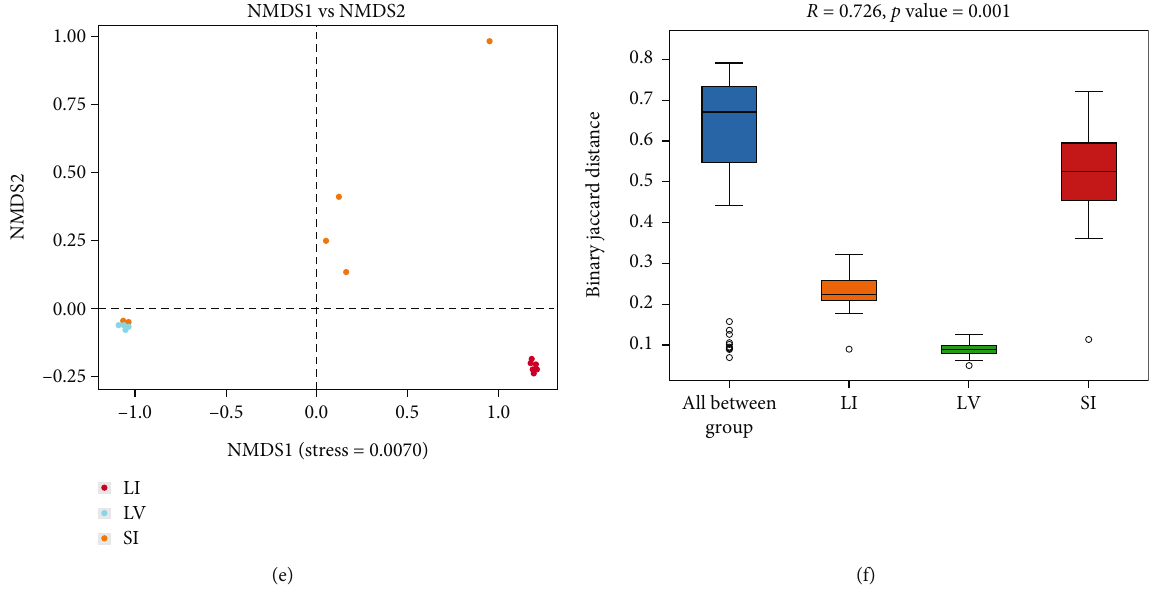
Figure 5: Alpha and beta diversity in liver and intestinal bacteria composition. Liver bacteria showed signi fi cantly higher richness and evenness than gut bacteria. The liver bacteria of di ff erent individuals were signi fi cantly more similar than the intestinal bacteria (genus level, binary Jaccard method). (a) Rank abundance curve of liver and intestinal bacteria. (b) Indices of α -diversity. ∗ compared with SI and LI, P < 0 : 05 . Simpson index was calculated as 1- ∑ pi 2 . (c) Principal component analysis (PCA). (d) Principal coordinate analysis (PCoA). (e) Nonmetric multidimensional scaling (NMDS) analysis. (f) Analysis of similarity (ANOSIM). LV: liver; LI: large intestine (feces); SI: small intestine